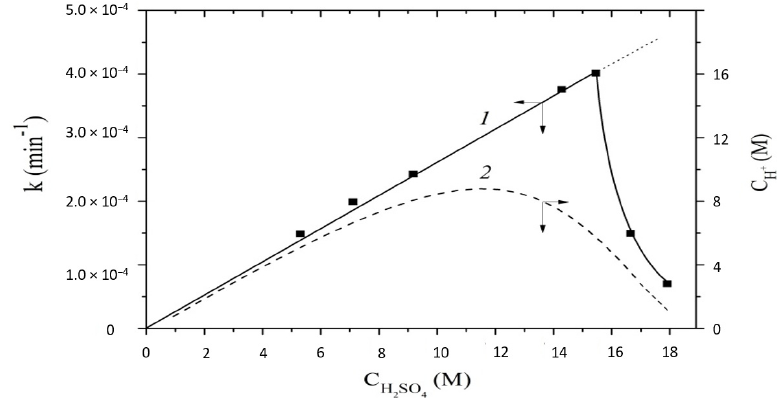
Figure8. Acomparisonoftheobservedconstantsofilmeniteleachingrate(line1)withtheconcentrations Figure 8. A comparison of the observed constants of ilmenite leaching rate (line 1) with the of H + in the solutions (line concentrations of H + in the solutions (line 2).